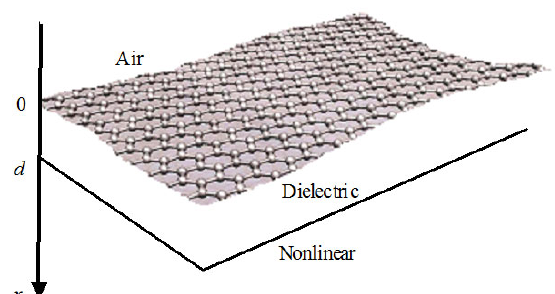
Fig. 1 Proposed structure. The field is assumed to travel along the z